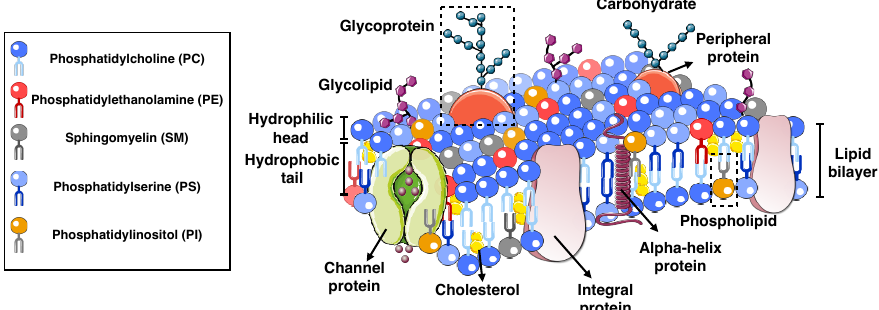
Figure 2. Schematic depiction of a cellular membrane highlighting its composition. There are two layers of amphipathic lipid molecules that self-assemble to form the bilayer. In each layer, the hydrophilic head groups form the outer surface and the hydrophobic tails face toward each other in the interior region. The distribution and organization of lipids and different proteins can vary from cell to cell. The cell membrane is composed of many different molecules including peripheral proteins,